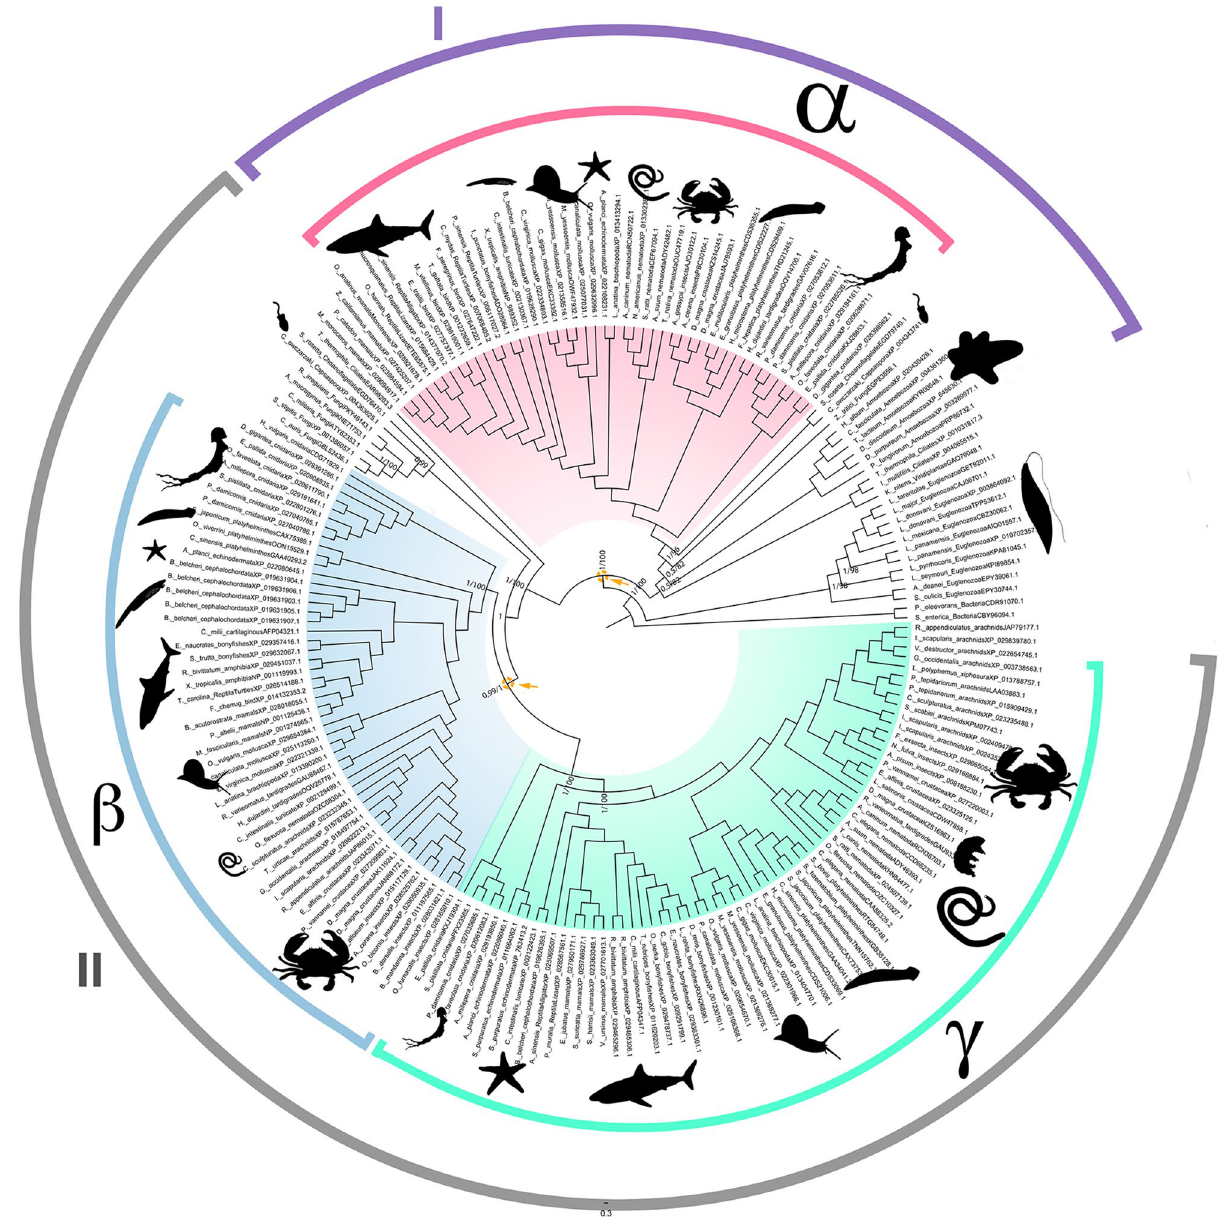
Figure 1. NAD-isocitrate dehydrogenase gene tree rooted with two bacterial sequences. Clade I is composed of eukaryotic catalytic subunits, and Clade II consists of eukaryotic regulatory subunits. The pink clade refers to metazoan catalytic subunit α, the blue clade refers to metazoan regulatory subunit β, and the green clade is the metazoan regulatory subunit γ. Arrows indicate gene duplication events that led to the evolution of NAD-IDH functional subunits. The number after the taxon name indicates the genetic identifier (GenBank) for each gene. Posterior probabilities and bootstrap support values are indicated for discussed nodes